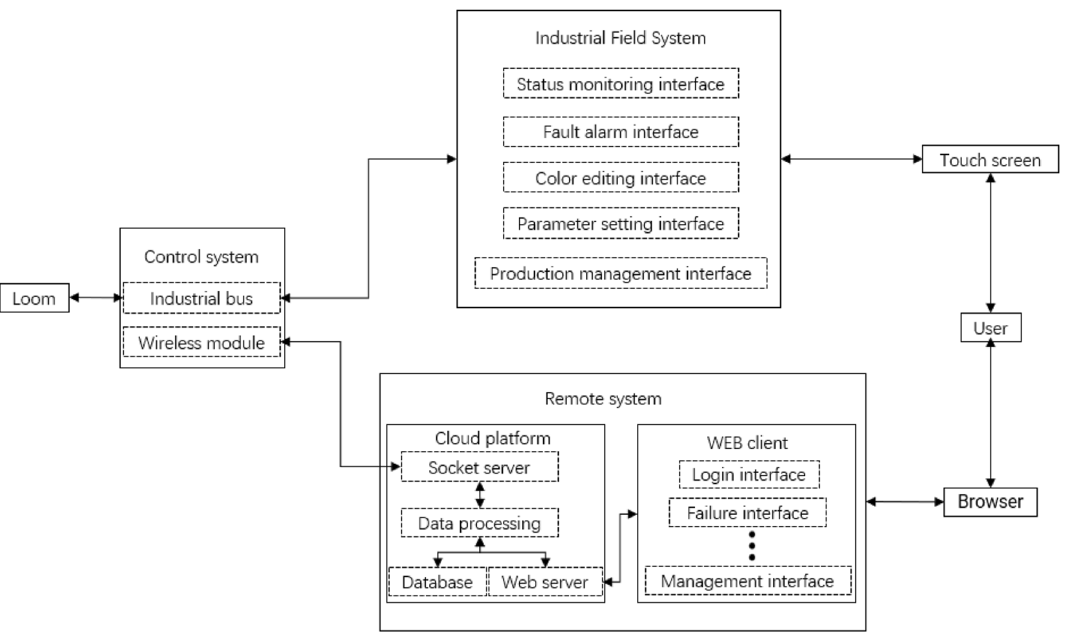
Fig. 2 The overall structure of the loom monitoring system